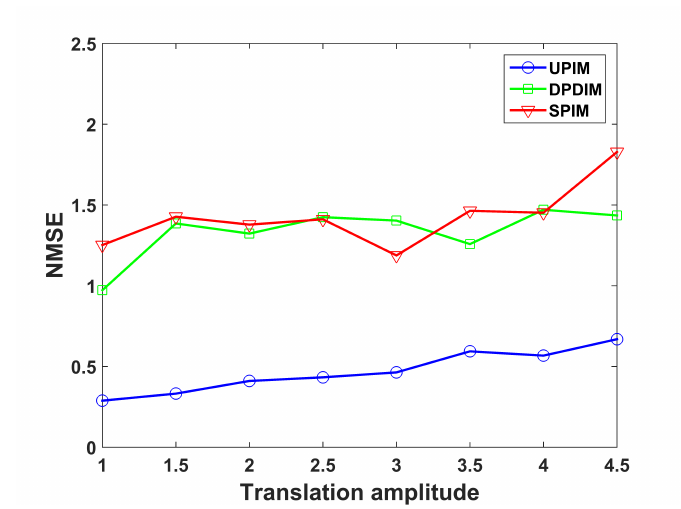
Figure 10. NMSE of the imaging results by UPIM, DPDIM, and SPIM at different amplitudes of translation.